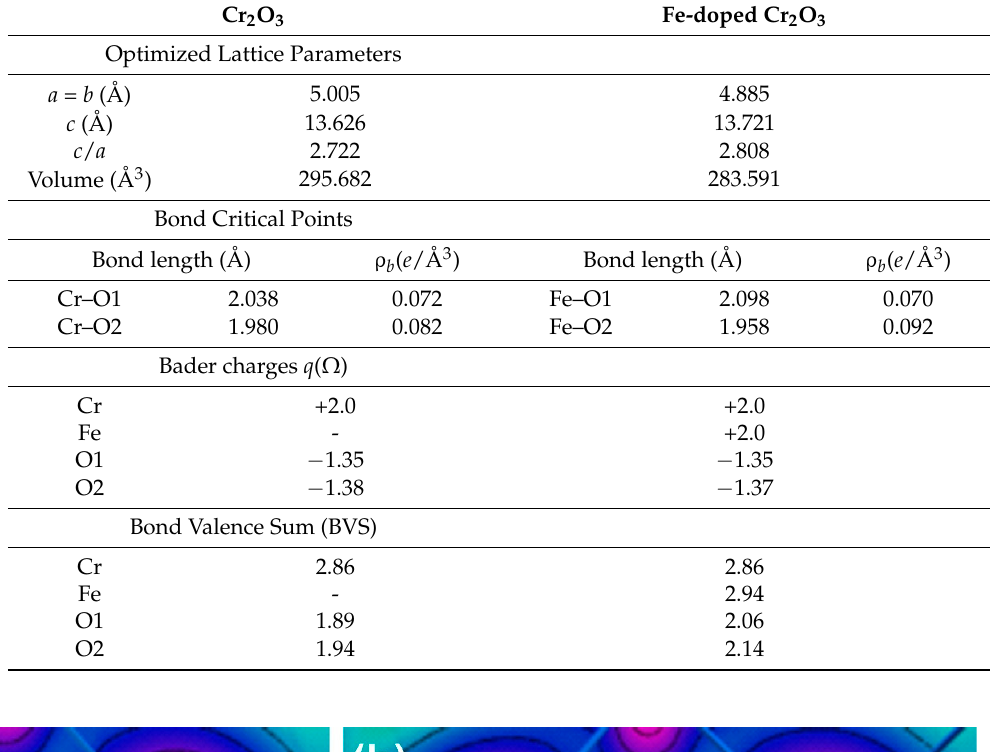
Table 2. Calculated properties based on structural (lattice constants and BVS data) and electronic (Bader’s charges and critical bond points) analyses for the Cr 2 O 3 and Fe-doped Cr 2 O 3 compounds. The O1 and O2 oxygens indicate the non-equivalent ligands, which compose the local structure around the Cr site and of the Fe-defect.